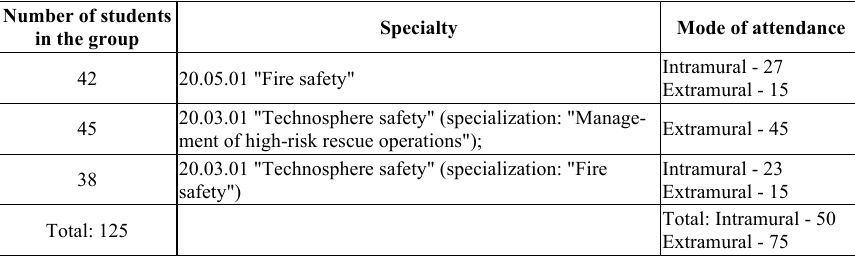
Table 3. Participants in the educational